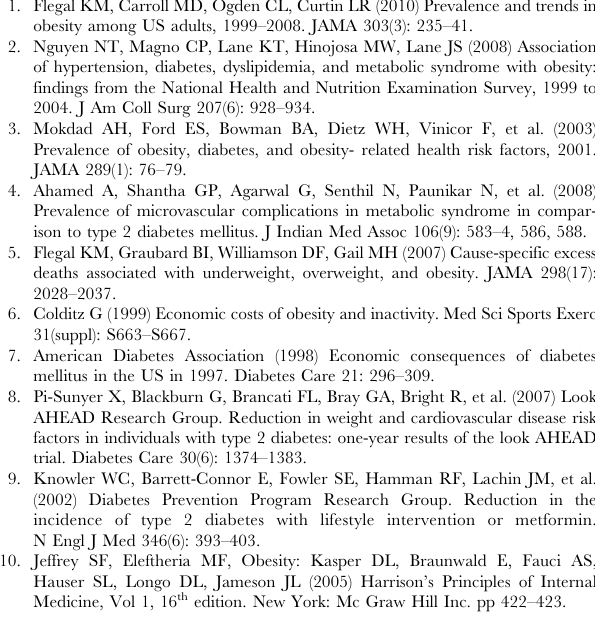
Table S1 Medication details of the study participants at